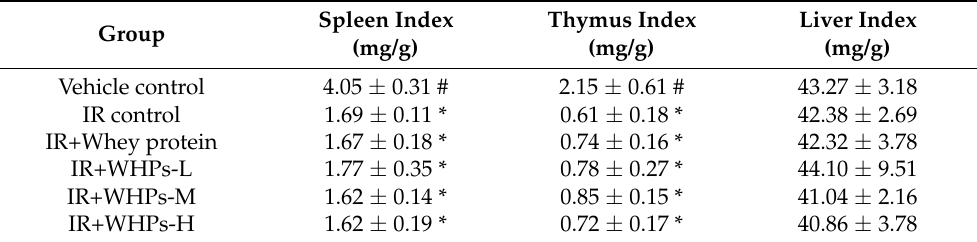
Table 4. Effects of WHPs on organ index in BALB/c mice at day three after radiation ( n = 12, x ± s).